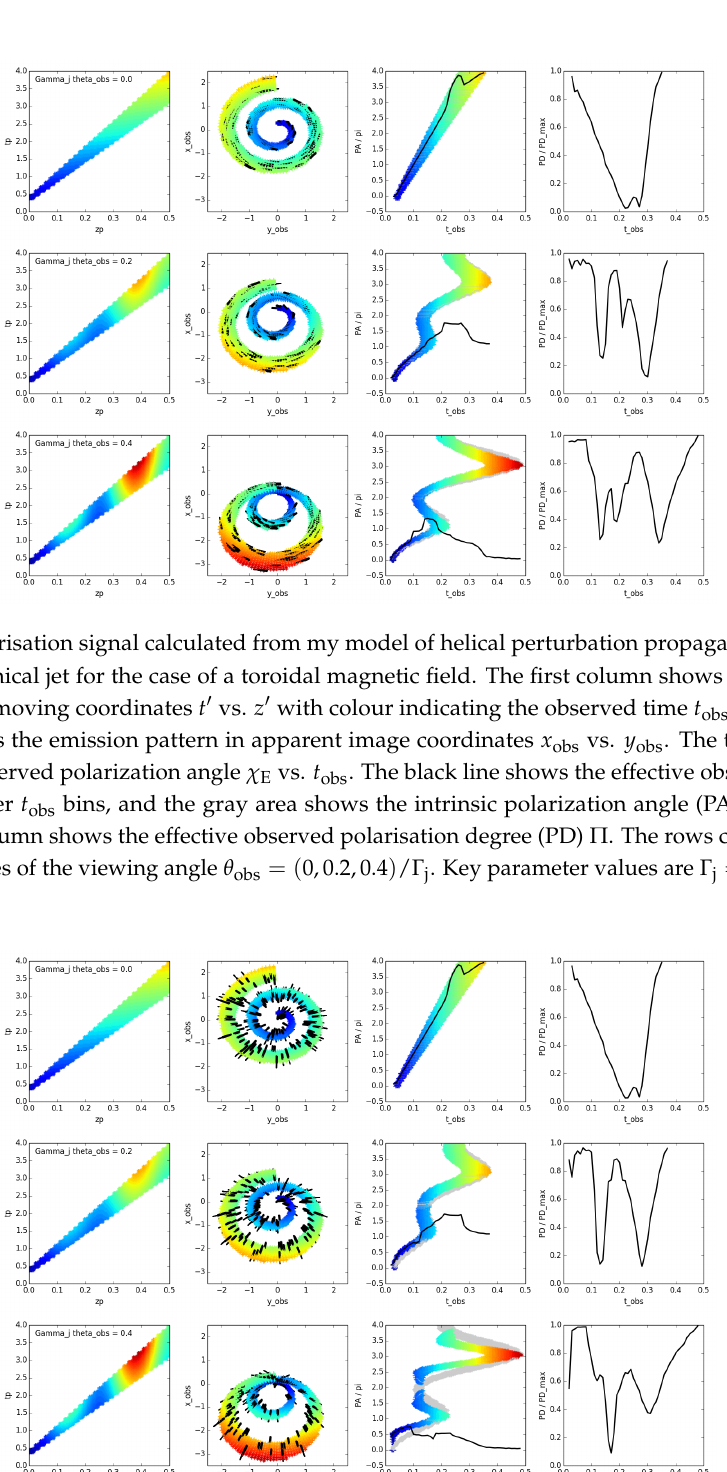
Figure 3. Same as Figure 2, but for the case of a poloidal magnetic